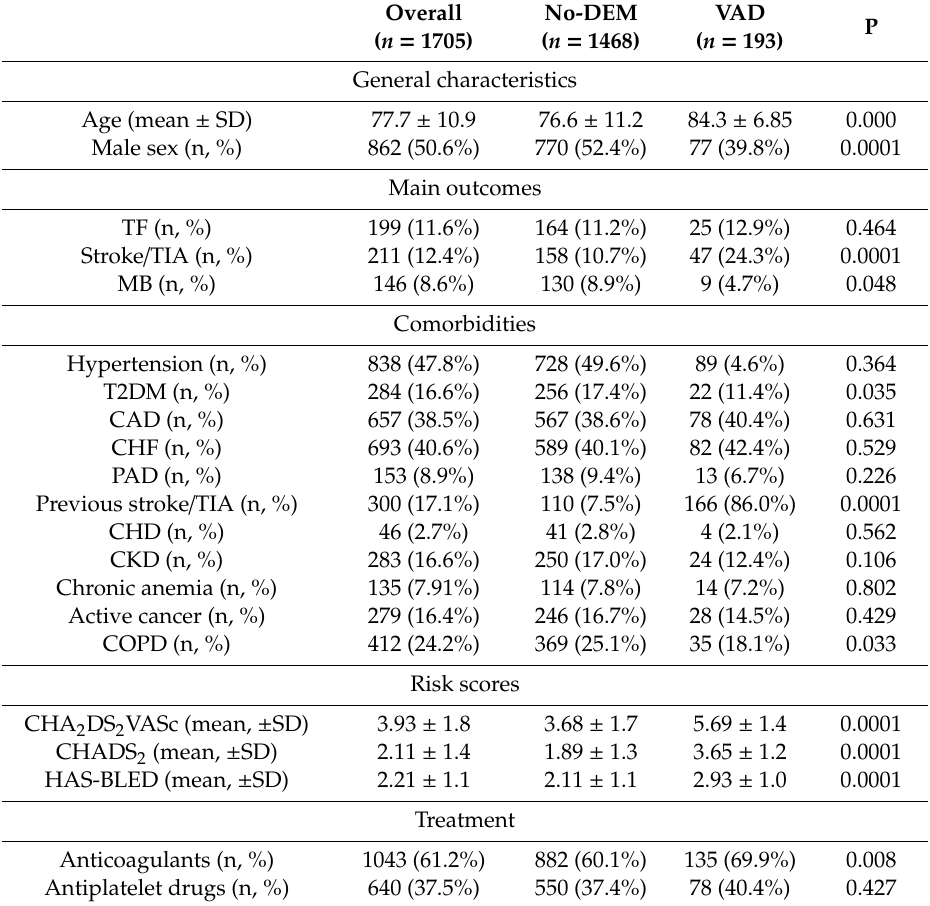
Table 1. Baseline di ff erences between patients not a ff ected by any form of dementia (No-DEM) and vascular dementia (VAD) subjects.